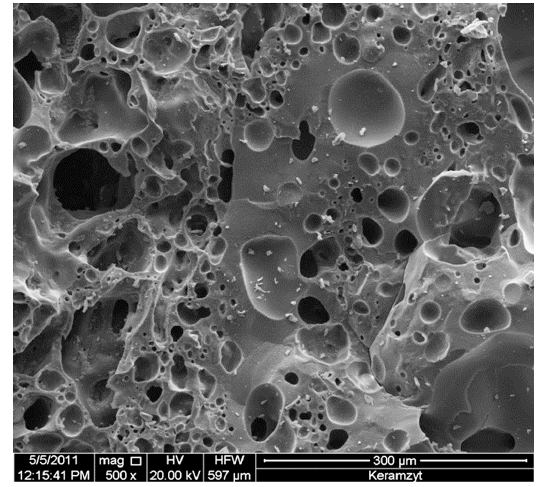
Figure 4. Scanning microscope image of the structure of lightweight aggregates.